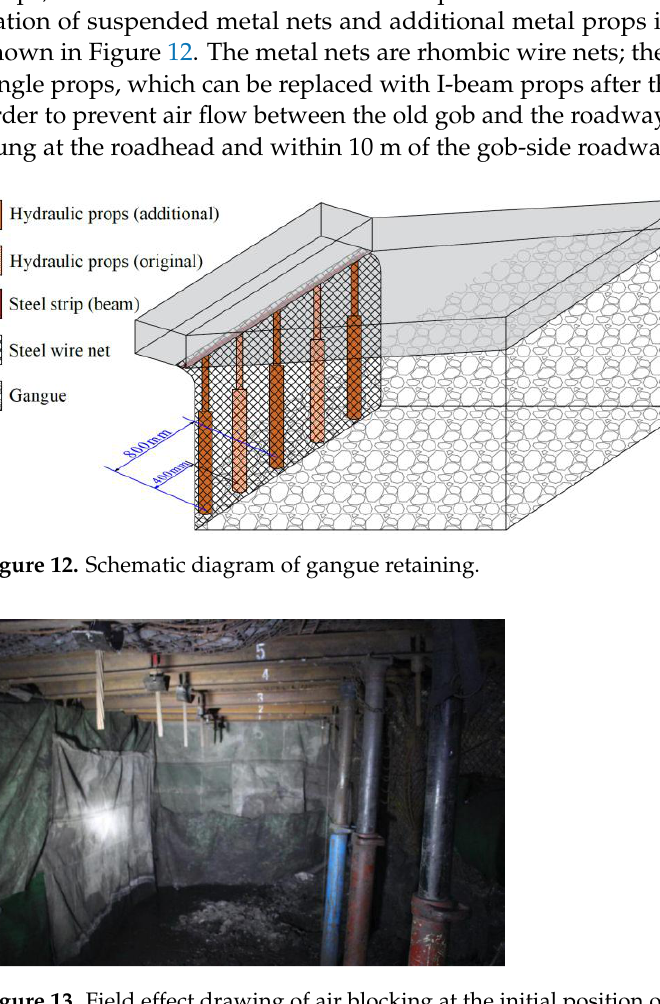
Figure 11. Overall support effect of the 1510 roadway.